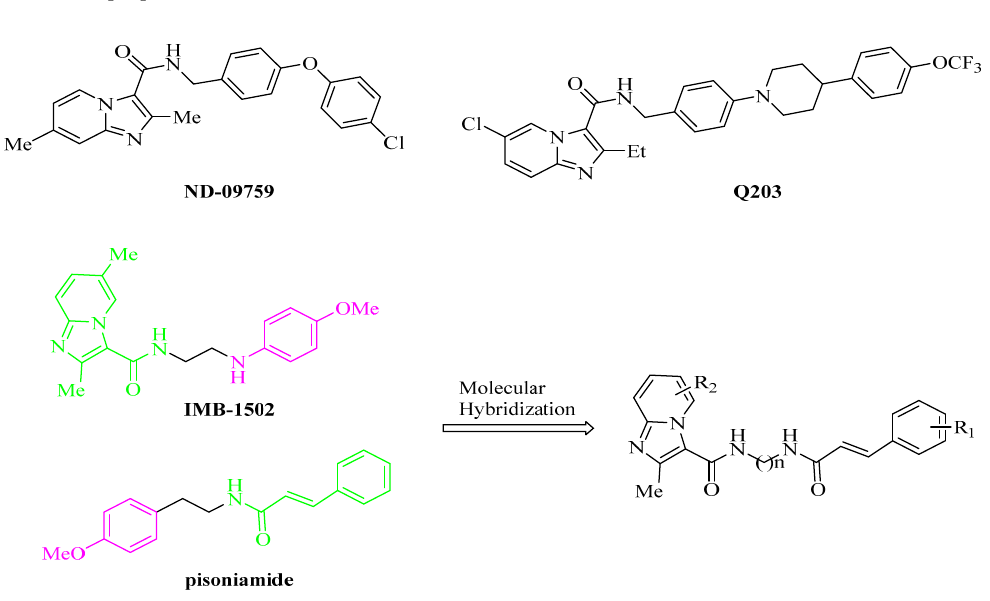
Figure 1. Structures of selected anti-tuberculosis (TB) compounds and the design of imidazo[1,2- a ] pyridine amide-cinnamamide hybrids.